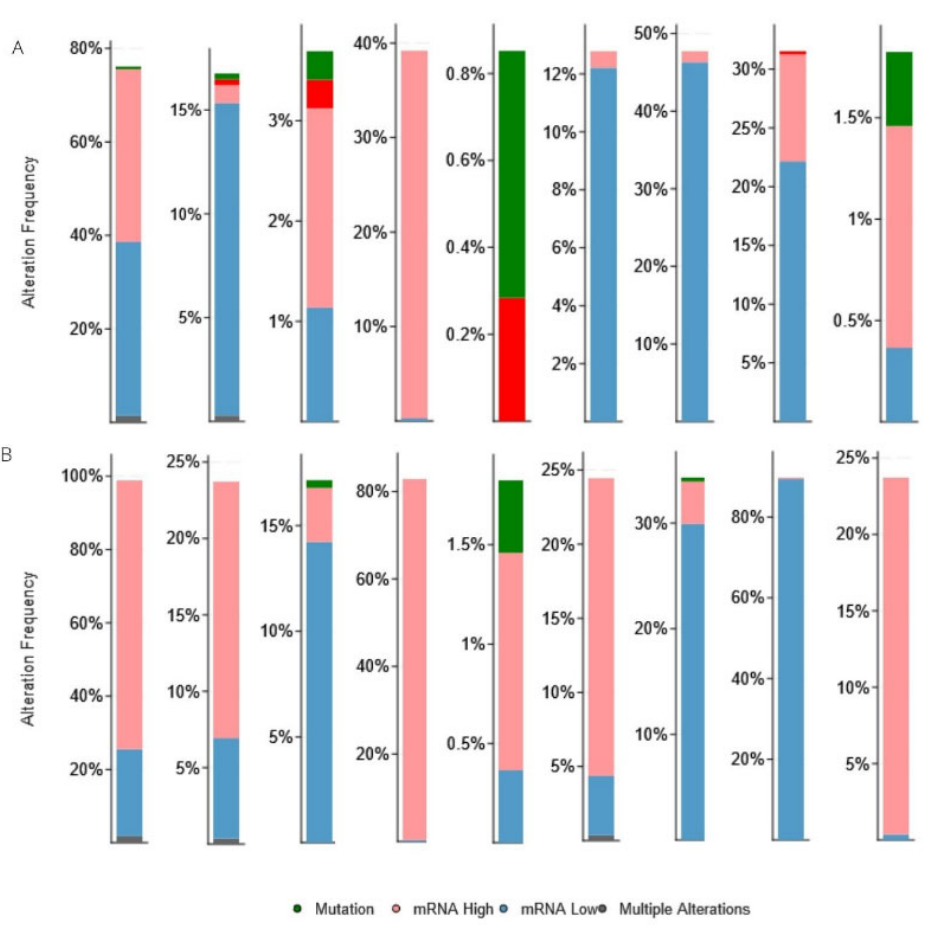
Figure 5. The alteration frequency and mechanisms for CBX family members in ( A ) ccRCC and ( B ) pRCC. relations between CBX6 with CBX3 (ccRCC: ρ = − 0.51, p = 3.36 − 24 ; pRCC: ρ = − 0.38, p = 8.78 − 11 ) and CBX8 (ccRCC: − 0.341, p = 4.60 − 11 ; pRCC: ρ = − 0.33, p = 2.05 − 8 ), for both RCC subtypes (Figure 6). Further, in the ccRCC group, we detected a positive correlation between CBX4 and CBX8 ( ρ = 0.53, p = 3.20 − 27 ), and a negative correlation between CBX3 and CBX7 ( ρ = − 0.41, p = 1.43 − 15 ). Differently, in the pRCC group, positive correlations were found between the pairs CBX2 with CBX4 ( ρ = 0.41, p = 1.17 − 12 ) and CBX5 with CBX6 ( ρ = − 0.39, p = 1.28 − 11